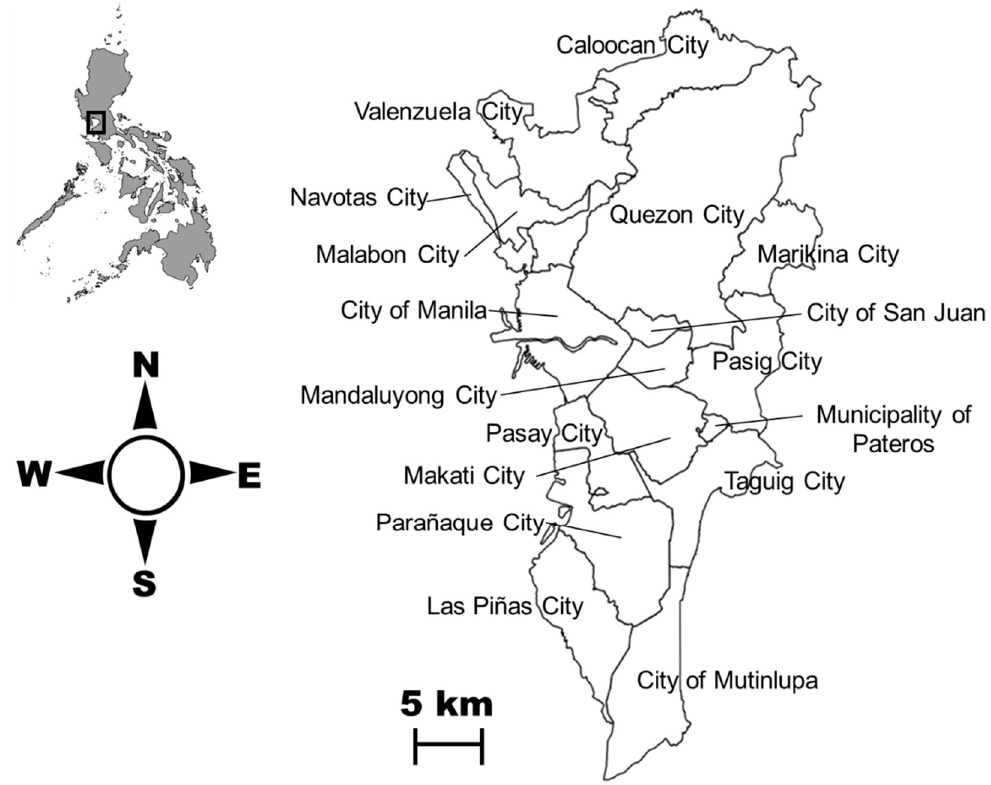
Figure 1. Administrative boundaries of Metropolitan Manila cities.